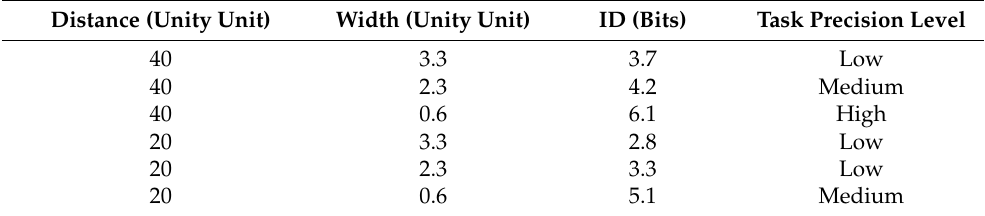
Table 1. ID and task precision level [8] .